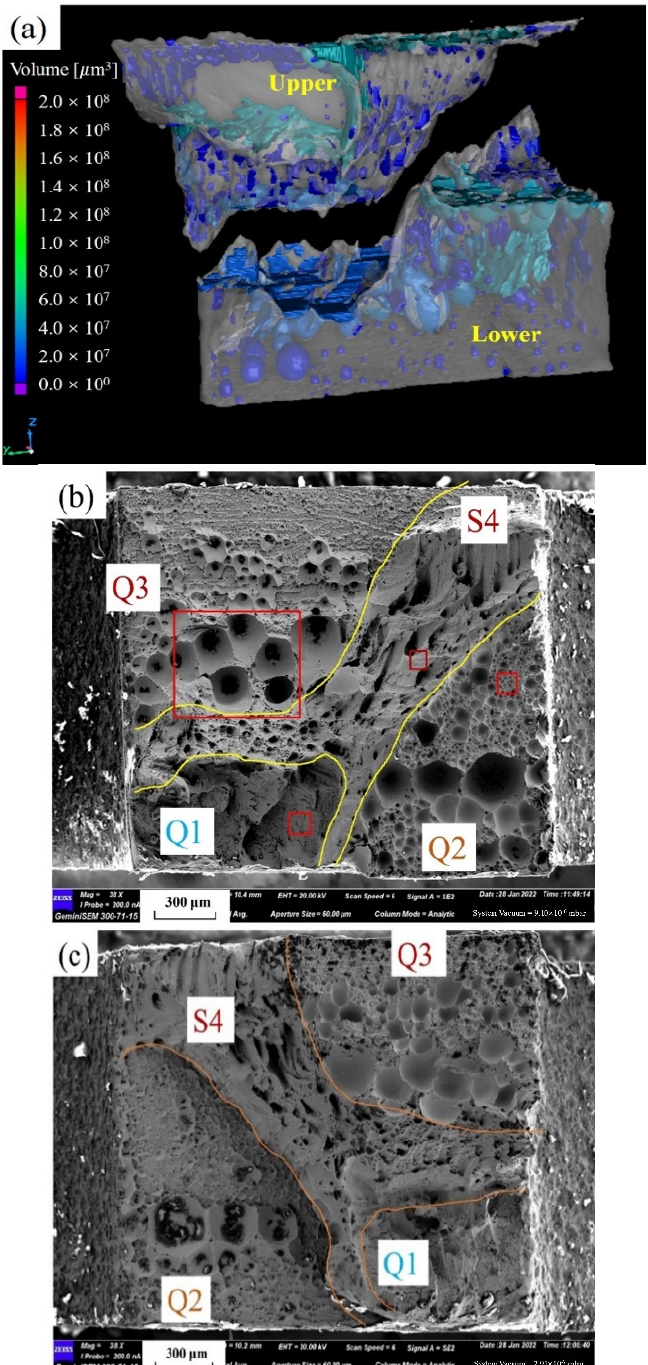
Figure 8. ( a ) Reconstruction of 3D internal structure of solder joint after fracture; ( b ) SEM fracture morphology of lower part; ( c ) SEM fracture morphology of upper part.